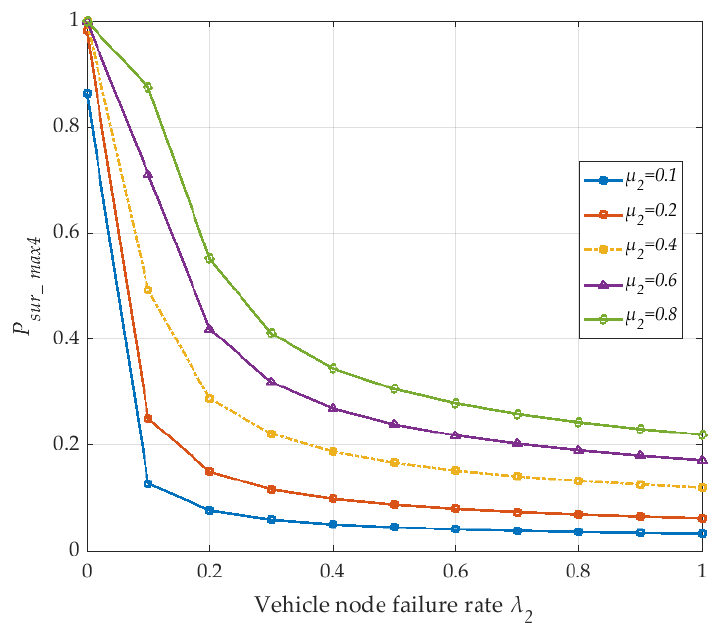
Figure 9. The maximum survival probability of the the V2I network with link failure rate λ 2 (corresponding to μ 1 and μ 2 ).